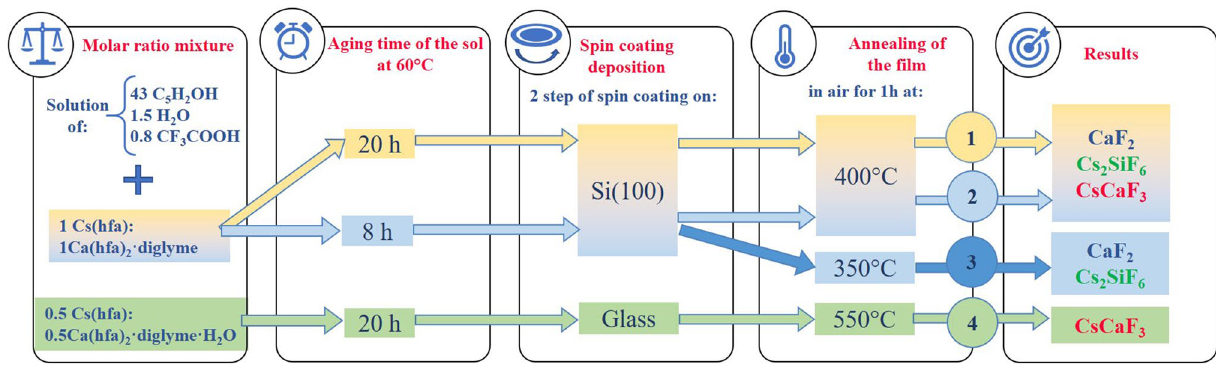
Fig. 2 XRD patterns of Cs-Ca films grown under different conditions: a route 1 with a molar ratio of the starting mixture 1: 1: 43: 1.5: 0.8, aging time 20 h, annealing tem- perature 400 °C, on Si (100) substrate; b route 2 with a molar ratio of 1: 1: 43: 1.5: 0.8, 8 h, 400 °C, on Si (100); c